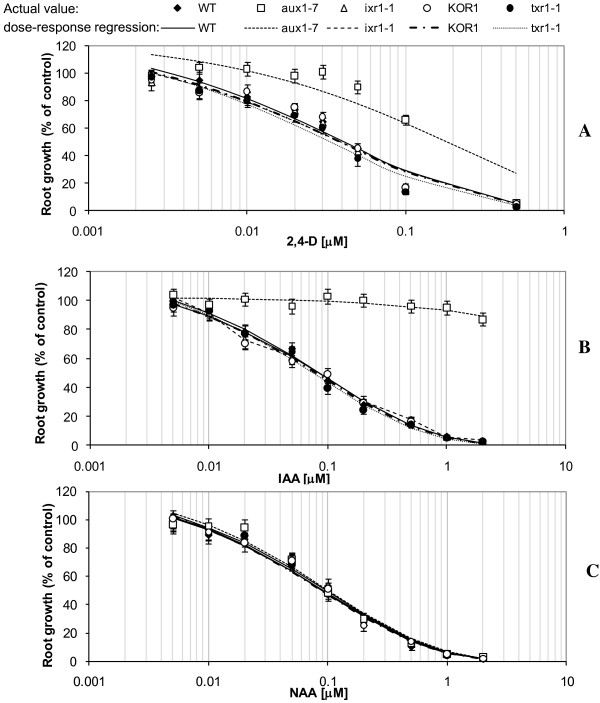
Root growth suppression of Arabidopsis lines in response to auxin treatment. Wild type and mutant Arabidopsis thaliana seedlings were treated for 72 h on medium containing: (A) 2,4-D; (B) IAA; (C) NAA. Individual data points are expressed as mean percentages ± SE (n = 20) of control root growth on medium with no auxin applied.